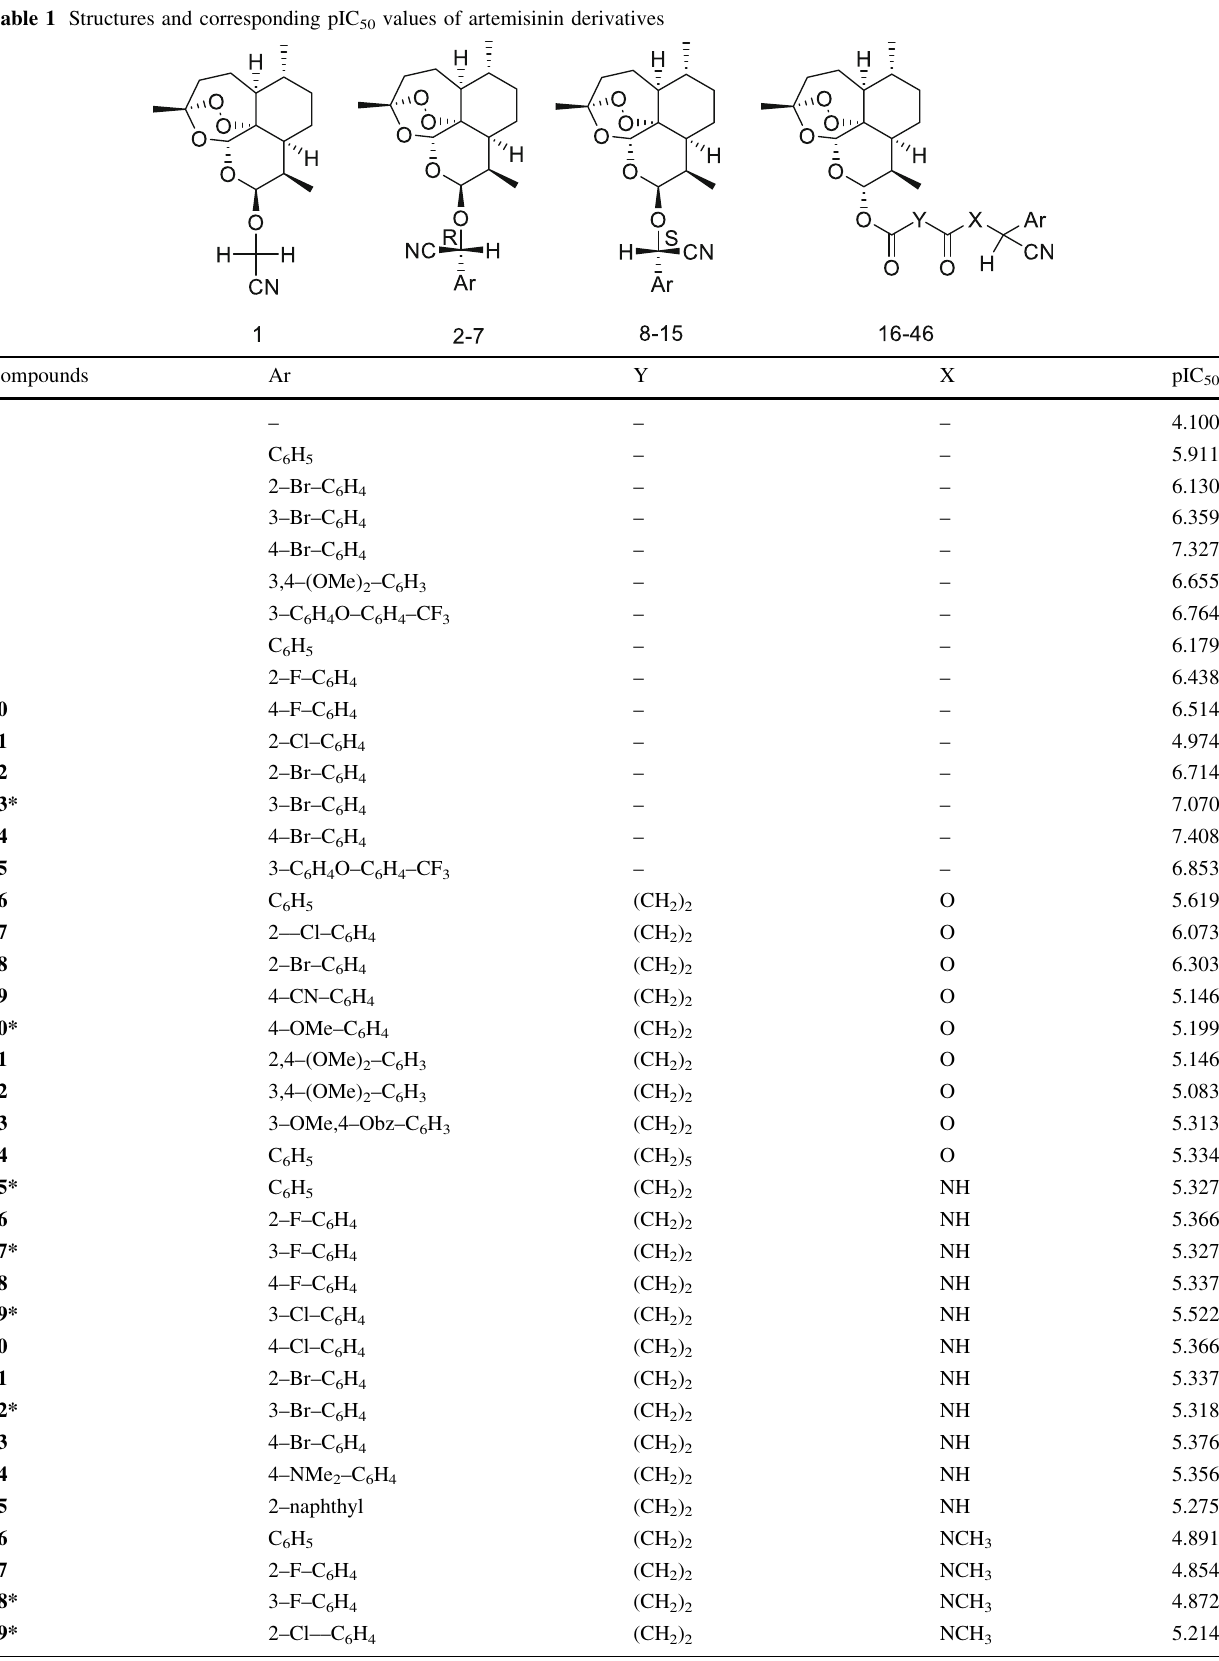
Table 1 Structures and corresponding pIC 50 values of artemisinin derivatives